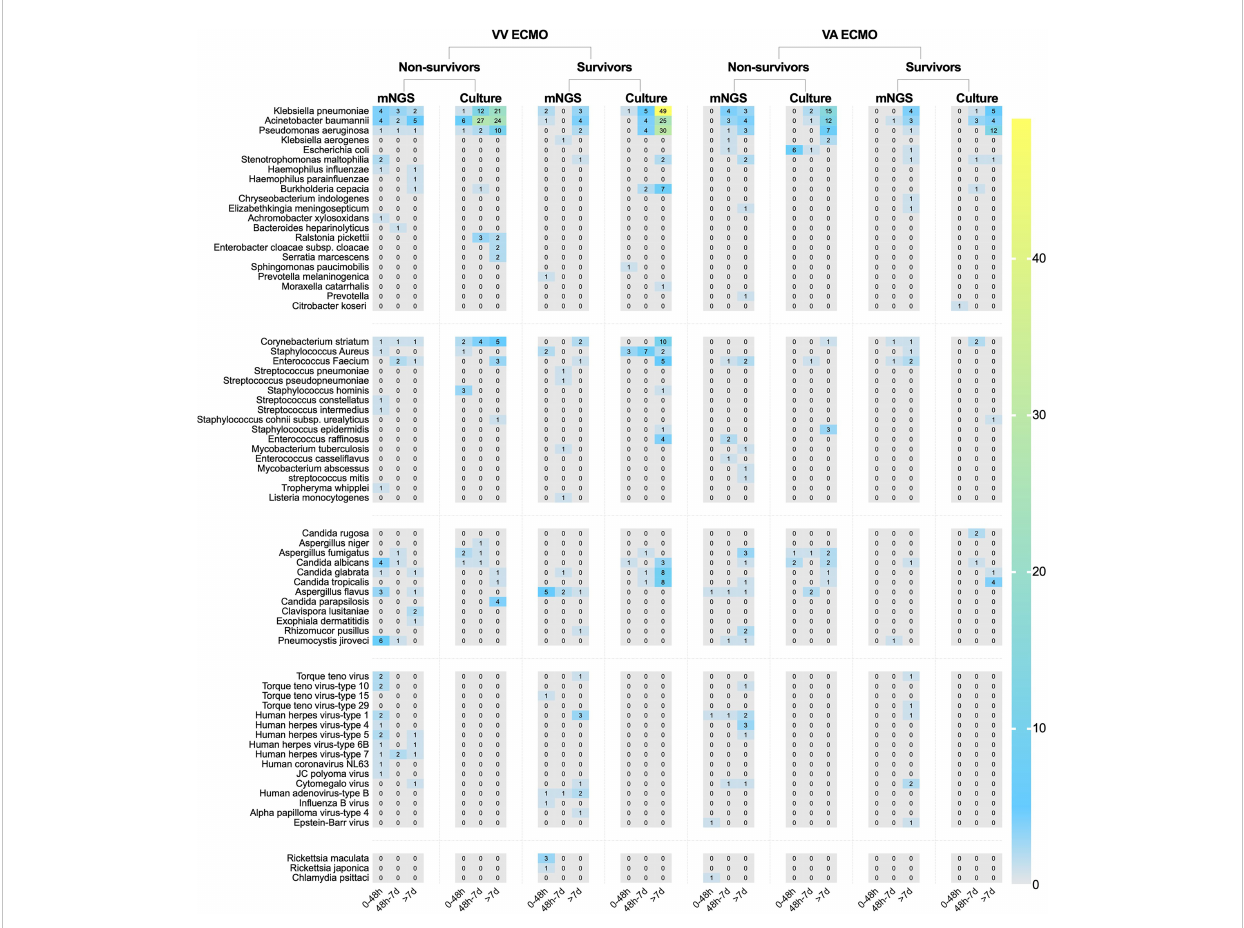
FIGURE 5 The heat map of pathogenic microorganism details in non-survivors and survivors of different ECMO assistance types (VV ECMO and VA ECMO) in different time periods (within 48 h after admission, between 48 h and 7 days of admission, and after 7 days of admission). ECMO, extracorporeal membrane oxygenation; VV, veno-venous; VA,